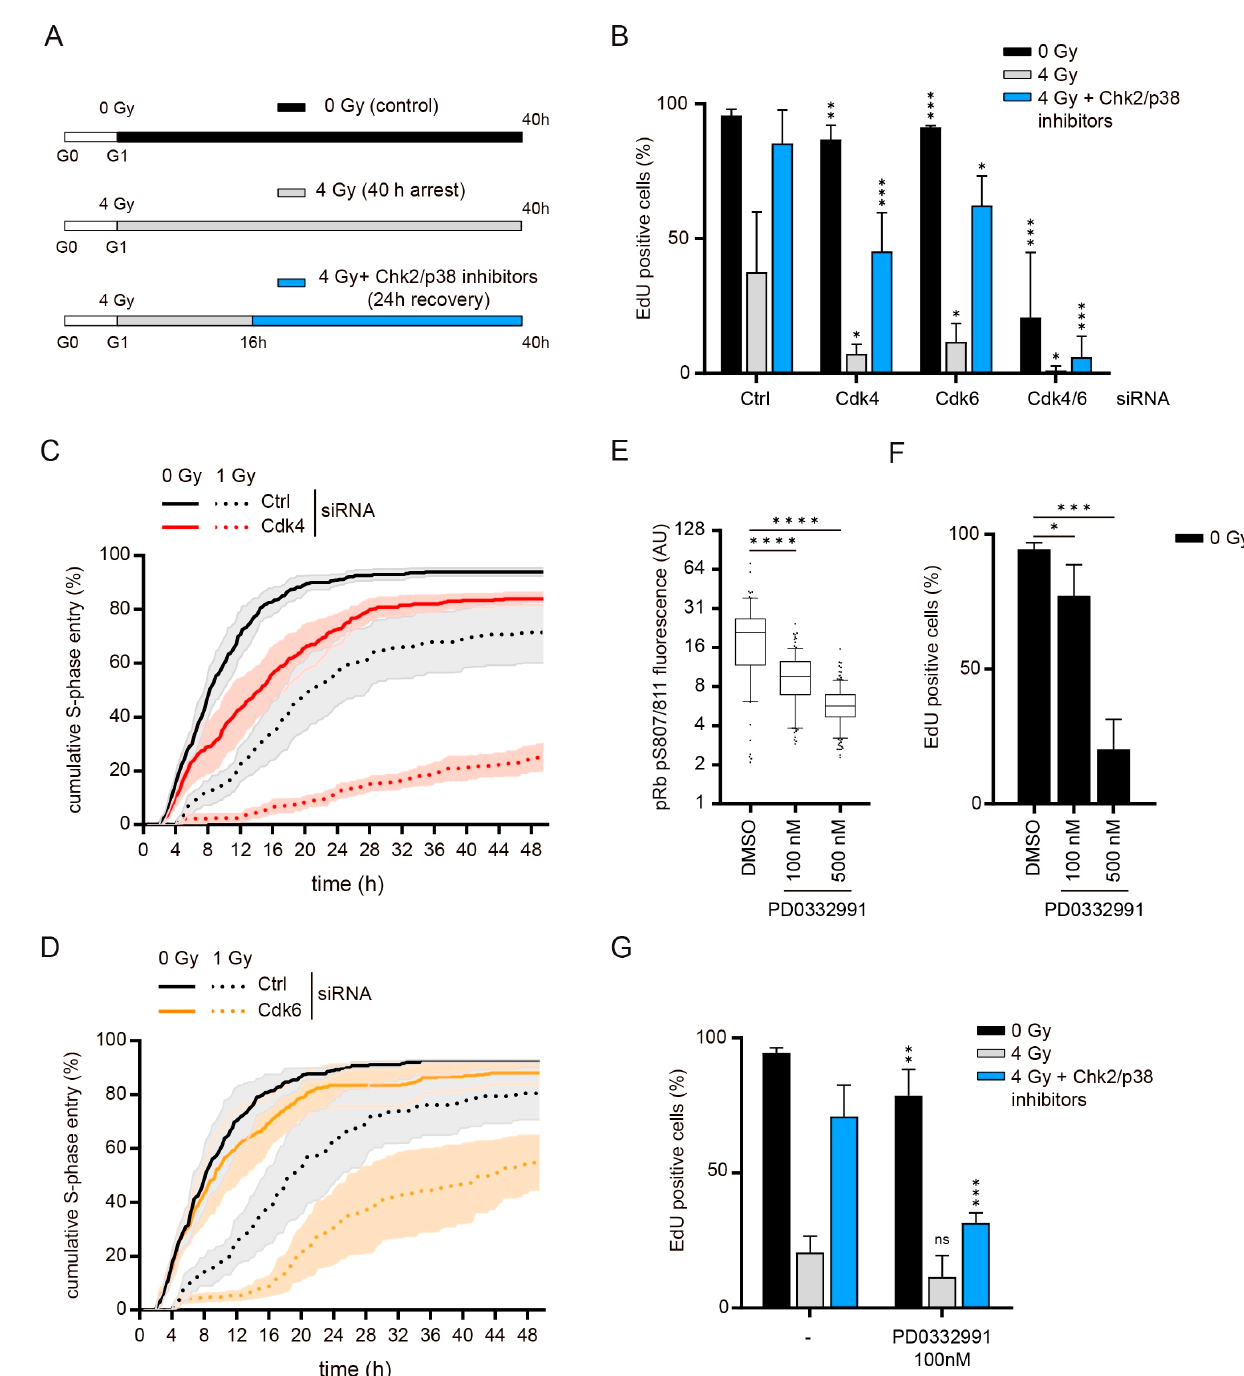
Figure 1. Cdk4 and Cdk6 are required to promote G1 checkpoint recovery: ( A ) G1 recovery assay. RPE-1 cells were synchronized in G0 by contact inhibition and 48 h of serum starvation. After 4 to 6 h of serum restimulation and EdU addition (G1), cells were mock-treated or irradiated with 4 Gy in G1. To study recovery from DNA damage, cells were left untreated or Chk2 and p38 inhibitors were added 16 h after irradiation for additional 24 h. ( B ) G1-synchronized RPE-1 cells were depleted of Cdk4 or Cdk6 by siRNA-transfection during serum starvation and treated as in ( A ). Percentage of cells entering S-phase was assessed by EdU incorporation. Depicted are the means and SD of four independent experiments. Significance was calculated by comparing different knock-downs to GAPDH-depleted control cells of similar irradiation regimen (e.g., Cdk4-depleted 4 Gy irradiated samples are compared to control-depleted 4 Gy irradiated samples). ( C , D ) Asynchronously proliferating RPE-FUCCI cells were subjected to time-lapse fluorescence microscopy 24 to 48 h after siRNA transfection. Cells in G1 at the start of the experiment were followed to determine cumulative S-phase entry. For